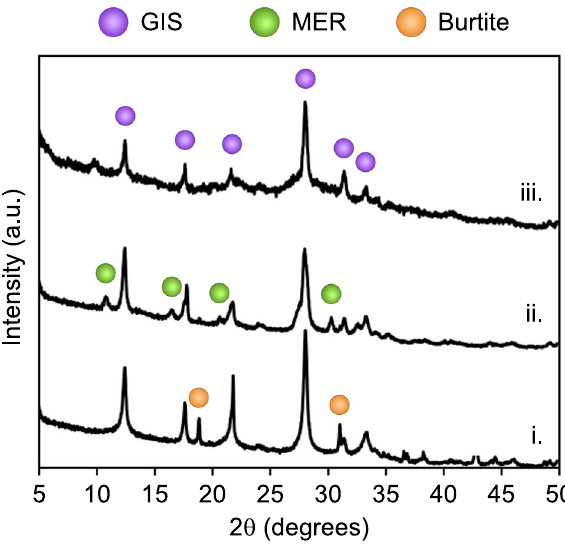
Fig. 6 Alkali metal substitution. Normalized PXRD patterns of products generated from a synthesis mixture designed to simulate the glass composition of eLAW-21 (Supplementary Table 2) with variations in the alkali metal content. Growth mixtures